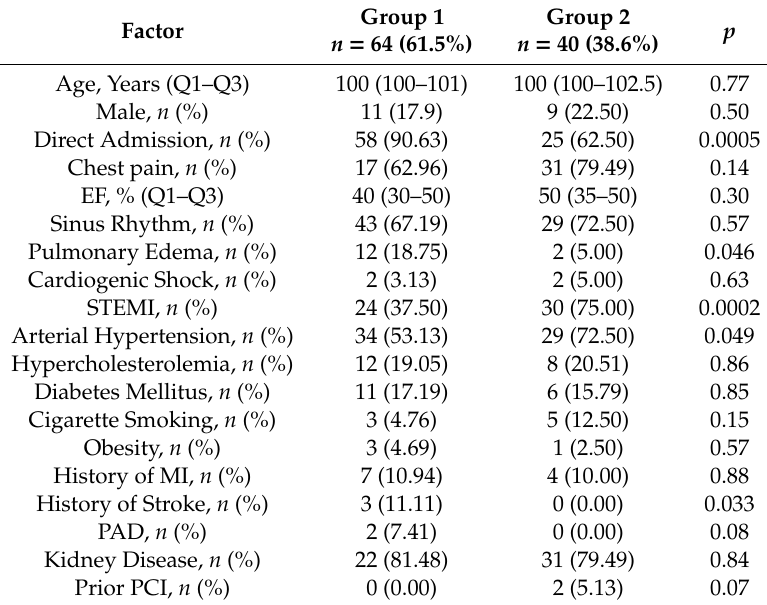
Table 1. Baseline clinical